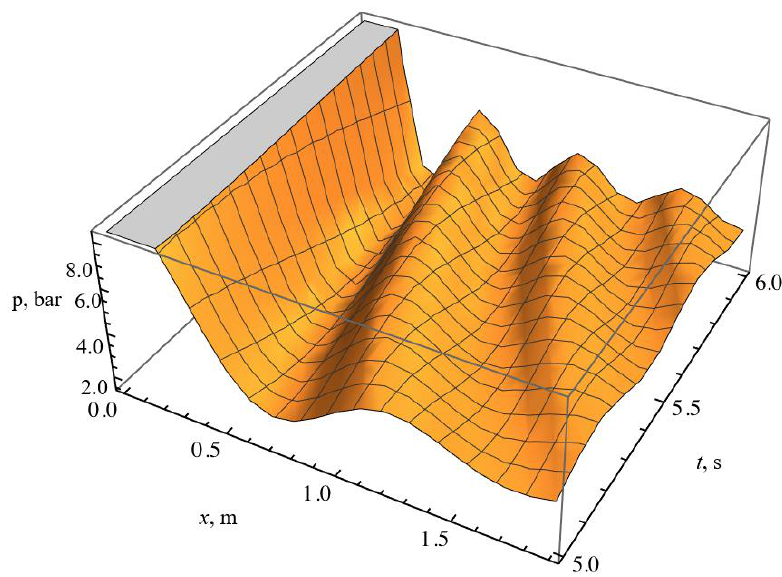
Figure 11. An example of pressure oscillations during the flame front propagation [9,11]. Obviously, the discrepancy between the real and approximating dependencies is not more than tenths of a percent.